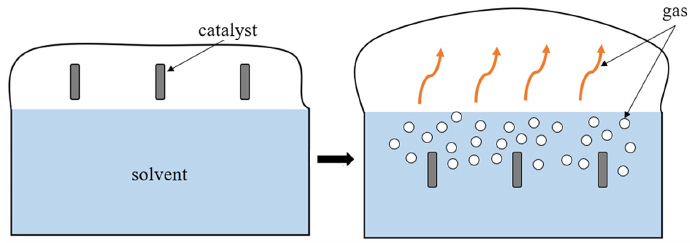
Figure 7. Schematic diagram of the reaction between hydrogen peroxide and catalytic silver.